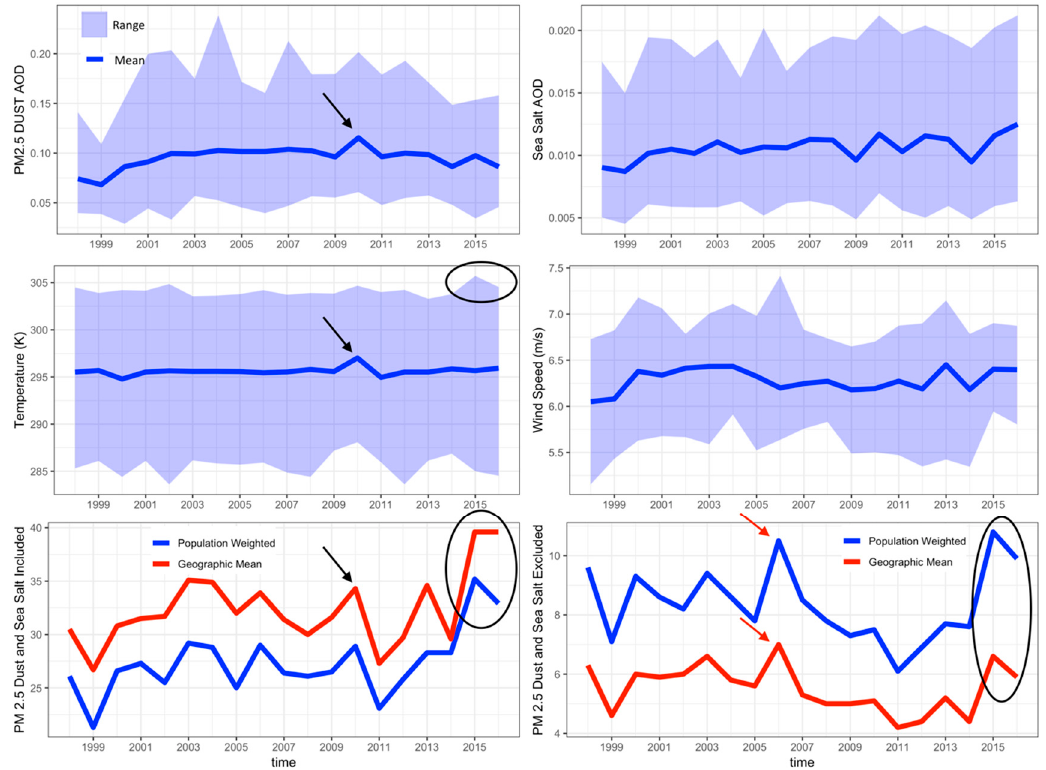
Figure 10. Egypt’s average annual population weighted and geographic mean PM2.5 using geographically weighted regression (GWR) datasets to compare with monthly MERRA-2 datasets (min, max, and mean values) of PM2.5 dust AOD and sea salt AOD, as well as surface air temperature and wind speed during the period from 1998 to 2016.